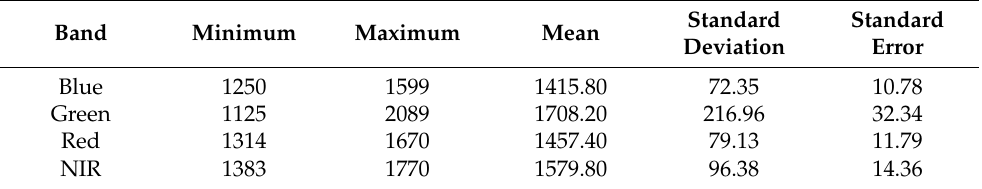
Figure 5. Variation as a function of the image number of the total number of matching points between the MicaSense ® RedEdge blue, green, red, or NIR band images and the red-edge band image. The points were extracted using the Speeded-Up Robust Features (SURF) features algorithm. Table 5. Descriptive statistics as a function of the band for the number of matching points obtained using the SURF features method over the blue, green, red, and NIR band images (moving images) and the red-edge band images (fixed image) of 45 multispectral images acquired with the MicaSense ® RedEdge camera.